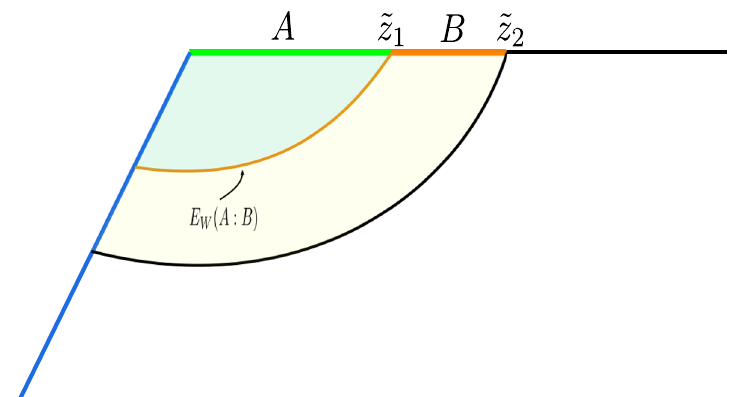
Figure 12. Schematics of the entanglement wedge cross section for the two adjacent intervals in phase-I conformally mapped the static mirror setup.